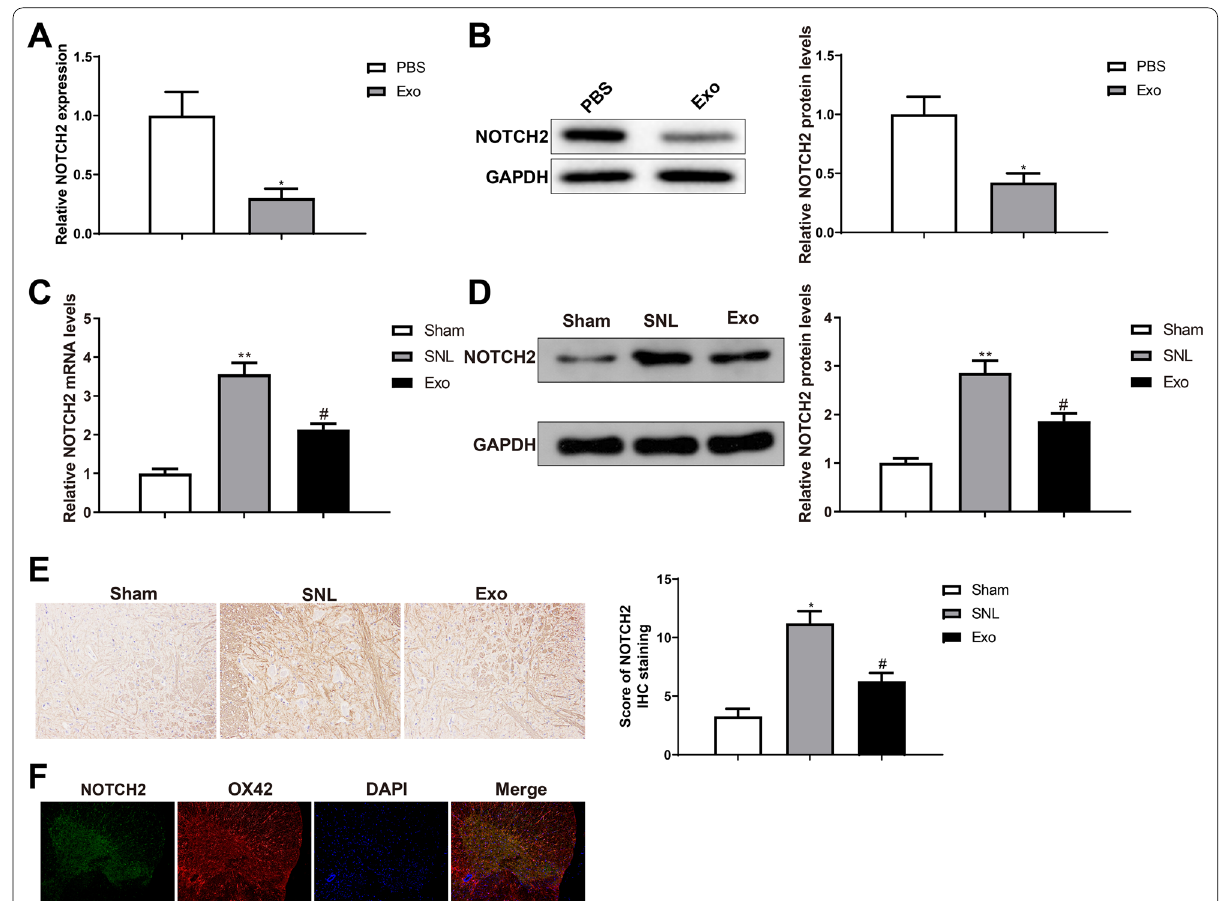
Fig. 4 BMSC-exosomes downregulate microglial NOTCH2 expression. RT-qPCR ( A ) and western blots ( B ) were used to detect NOTCH2 expression in microglial cells after BMSC-exosome treatment; RT-qPCR ( C ), western blotting ( D ), and immunohistochemistry ( E ) were used to detect the expression of NOTCH2 in SDH; ( F ) Double immunofluorescence staining was used to localize NOTCH2. Data were shown as mean deviation. N 6. * P < 0.05, vs. the sham group; # P < 0.05, vs. the SNL group. BMSC bone marrow mesenchymal stem cell, SDH spinal dorsal horn, SNL = spinal nerve